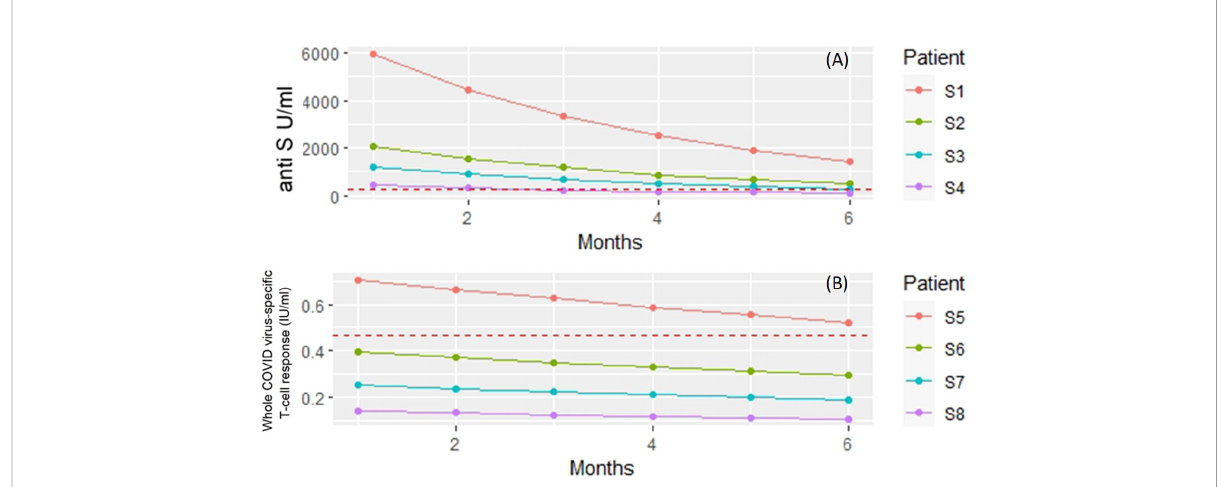
FIGURE 3 Linear regression models were built to investigate the dependence of anti-S titer and T-cell response on patient and treatment speci fi c factors. The fi gure shows the model predicted responses for four hypothetical patients (S1 – S8). (A) Predicted anti-S antibody concentrations following vaccination with BNT162b2. Subject 1 (S1) - 50 years old, no biology (TNF) treatment. Subject 2 (S2) - 75 years of age but no treatment with TNF inhibitor. Subject 3 (S3) - 50 years old and gets TNF inhibitor. Subject 4 (S4) 75 years of age and receiving TNF inhibitor therapy. Red dashed horizontal line: measured mean anti-S antibody levels in unvaccinated patients and volunteers. (B) Predicted whole COVID virus-speci fi c CD4+ and CD8+ T-cell responses following vaccination with BNT162b2. Subject 1 (S5) - 50 years old, no biological (rituximab) treatment. Subject 6 (S6) - 75 years of age but no treatment with rituximab. Subject 7 (S7) - 50 years old and gets rituximab. Subject 8 (S8) 75 years of age and receiving rituximab therapy. Red dashed horizontal line: measured mean whole COVID virus-speci fi c CD4+ and CD8+ T-cell response levels in unvaccinated patients and volunteers.